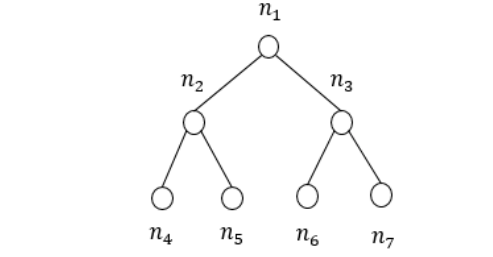
Figure 4. VP-tree generation.